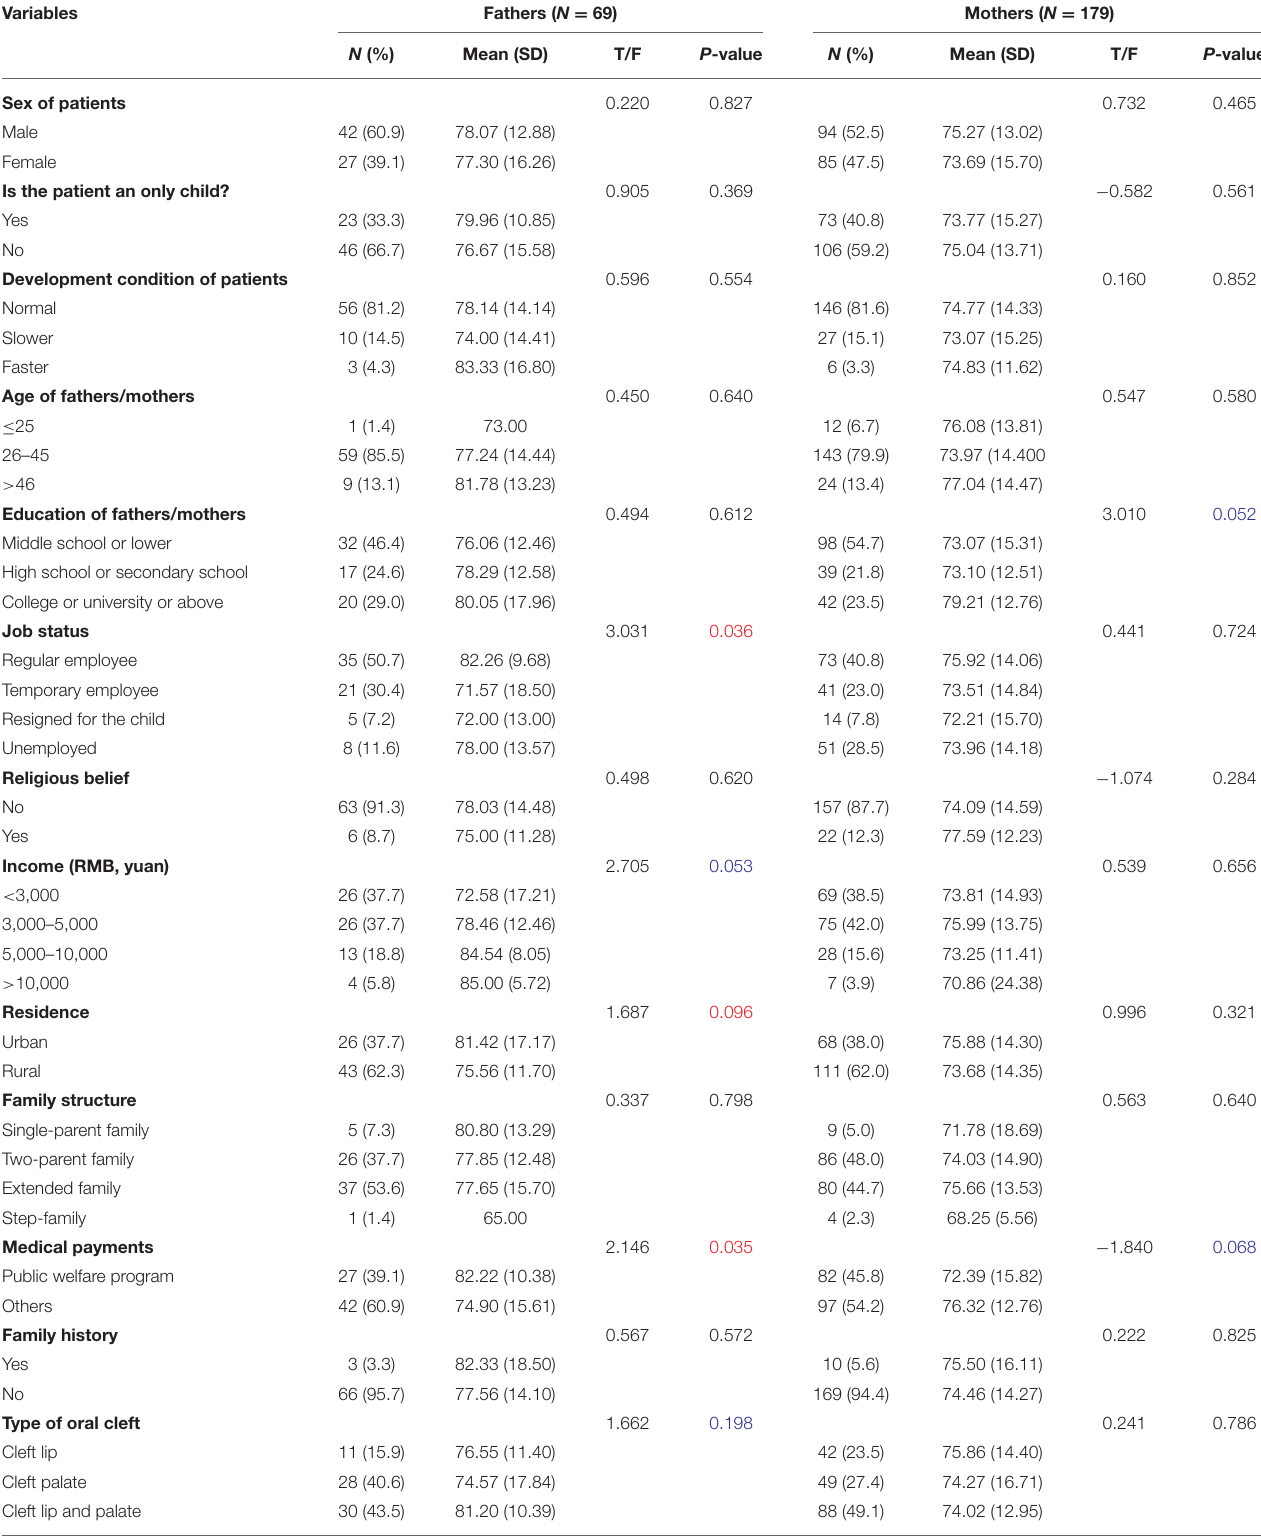
TABLE 1 | Demographic and clinical characteristics and the level of resilience among fathers and mothers of patients with CLP ( n = 248).